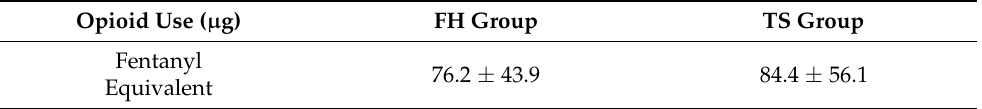
Table 7. Opioid usage at post-anesthesia care unit. Opioid Use ( µ g)